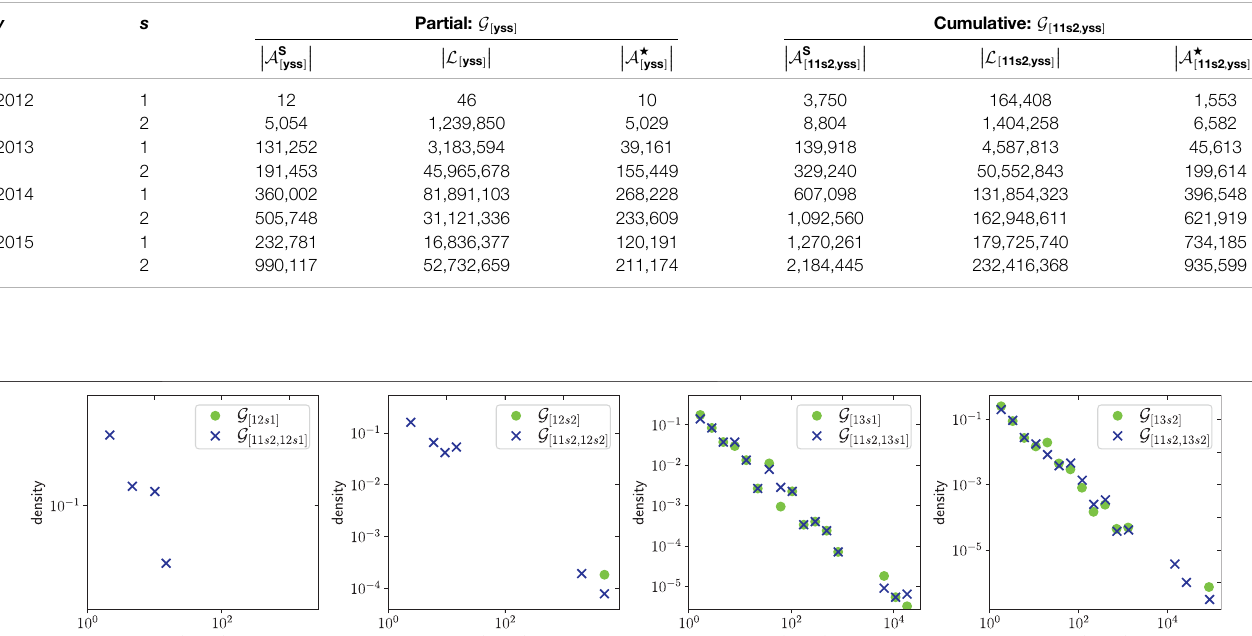
TABLE 1 | Number of nodes, edges and ground truth addresses of the partial and cumulative Address Correspondence Networks for each semester from 2012 to 2015.